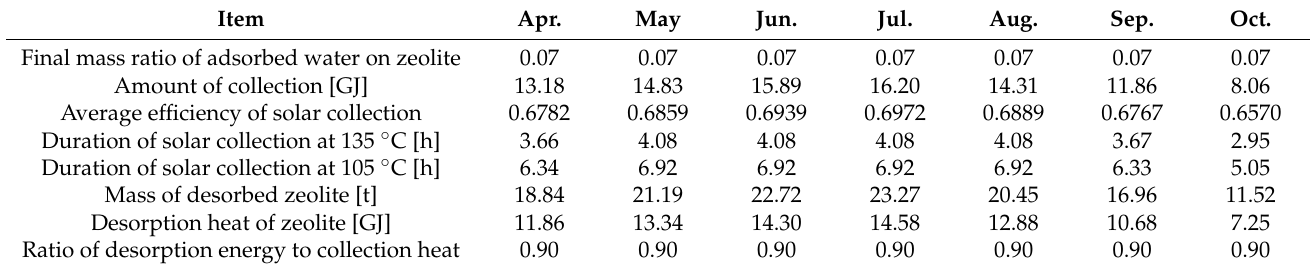
Table 2. Simulation results for a typical day of each month in the non-heating season.